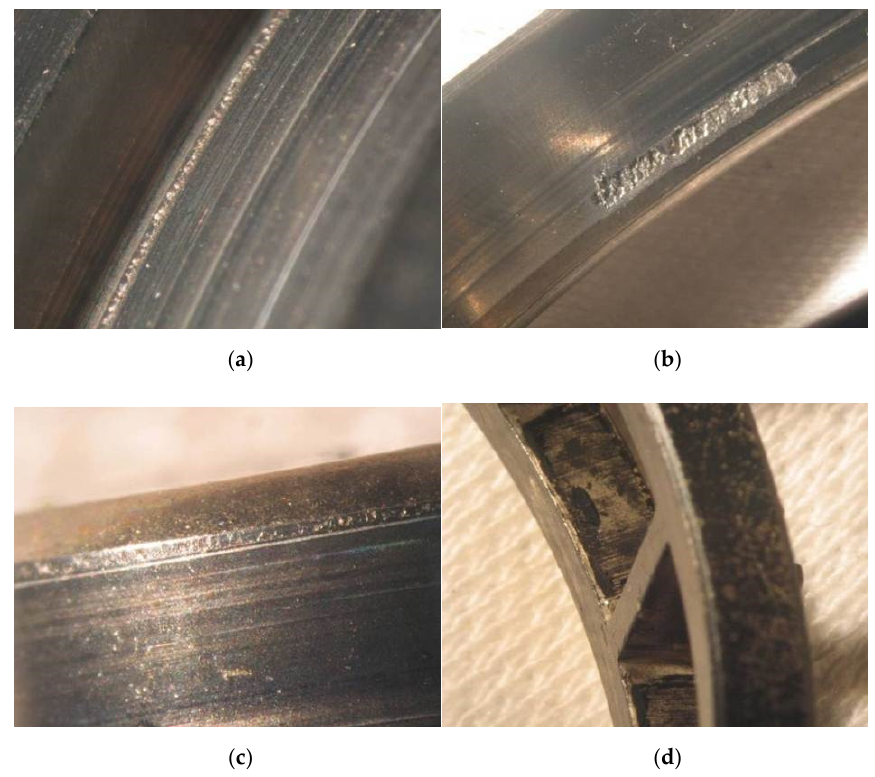
Figure 20. Damage morphology of the test verification bearing: ( a ) spalling morphology of the outer ring raceway; ( b ) spalling morphology of the outer ring raceway; ( c ) typical spalling morphology of the rollers; ( d ) wear morphology of the